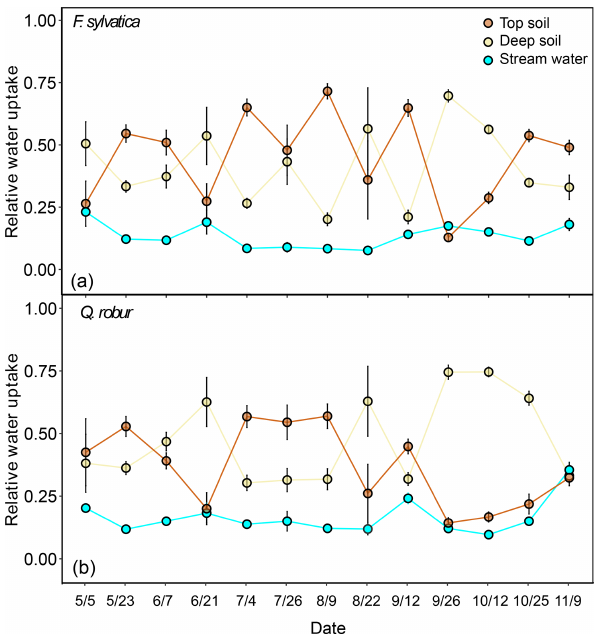
Figure 6. Relative water uptake from each of the plant water sources considered: topsoil, deep soil and stream water (indistinguishable with groundwater), as estimated with MixSIAR for the dominant trees of F. sylvatica (a) and Q. robur (b) . The error bars correspond to the standard deviation ( N = 15 for F. sylvatica and N = 9 for Q. robur ). These proportions were estimated with uncorrected δ 2 H and δ 18 O values for xylem